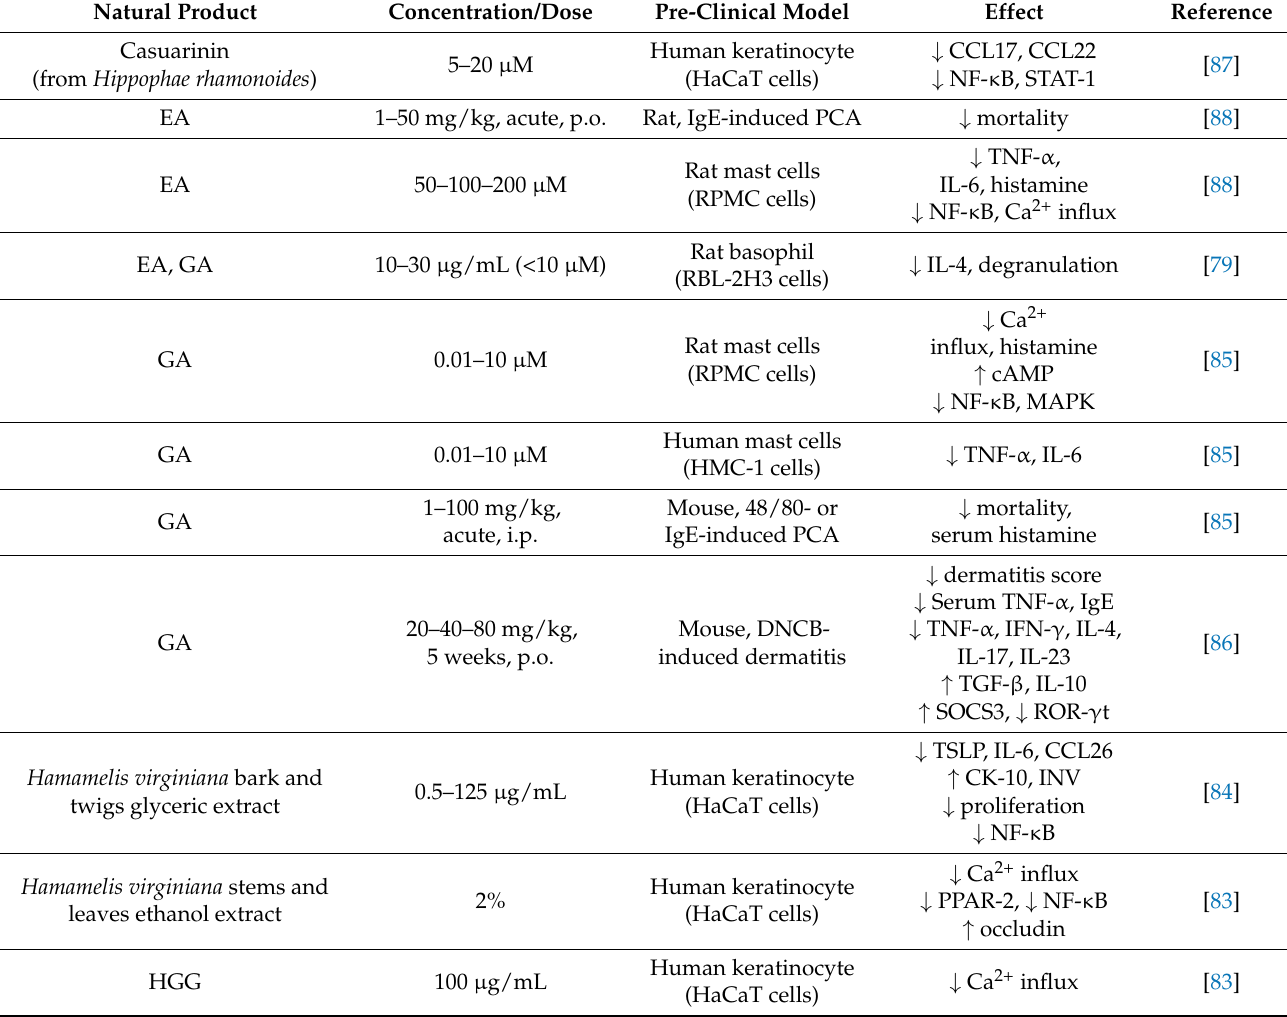
Table 4. Collection of recent articles concerning the biological activity of HTs and their metabolites in AD